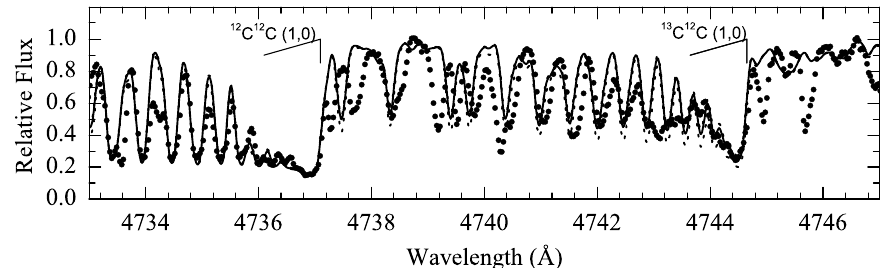
Fig. 10. The observed spectrum of HD 209621 in the wavelength range around the Swan system (1,0) band head. The C 2 synthetic spectra are given for the abundance of 12 C, log ϵ (C) = 7.85 and the three values of the ratio 12 C/ 13 C = 8, 17 and